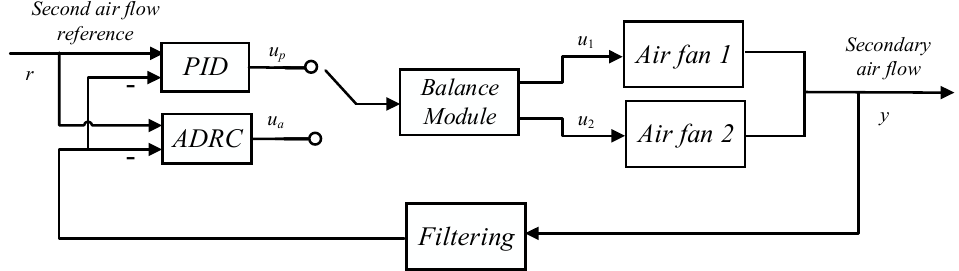
Figure 12. Schematic diagram of the secondary air control system.